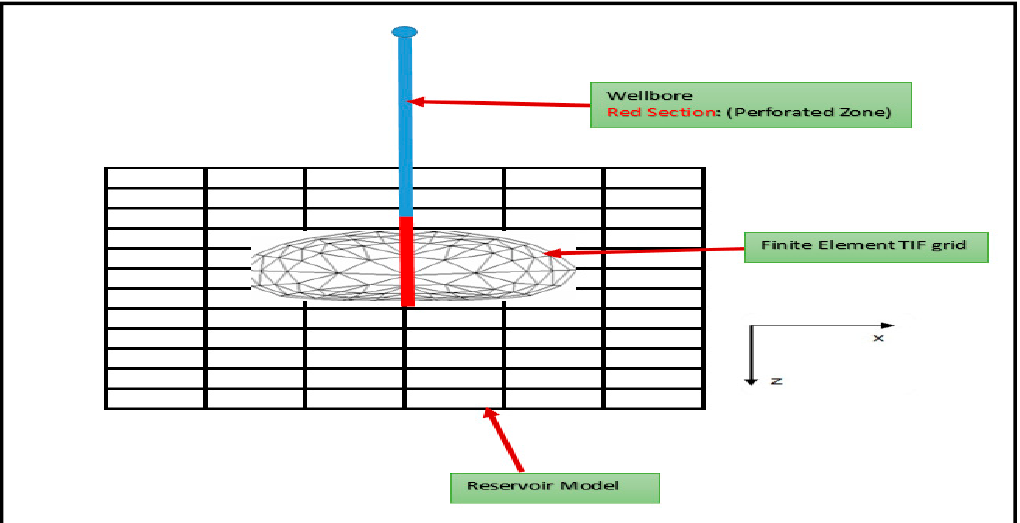
Figure 9. A vertical 2D finite element (FE) TIF model coupled with a finite difference (FD) reservoir model and derailed model of an injection well. Energies 2020 , 13 , x FOR PEER REVIEW